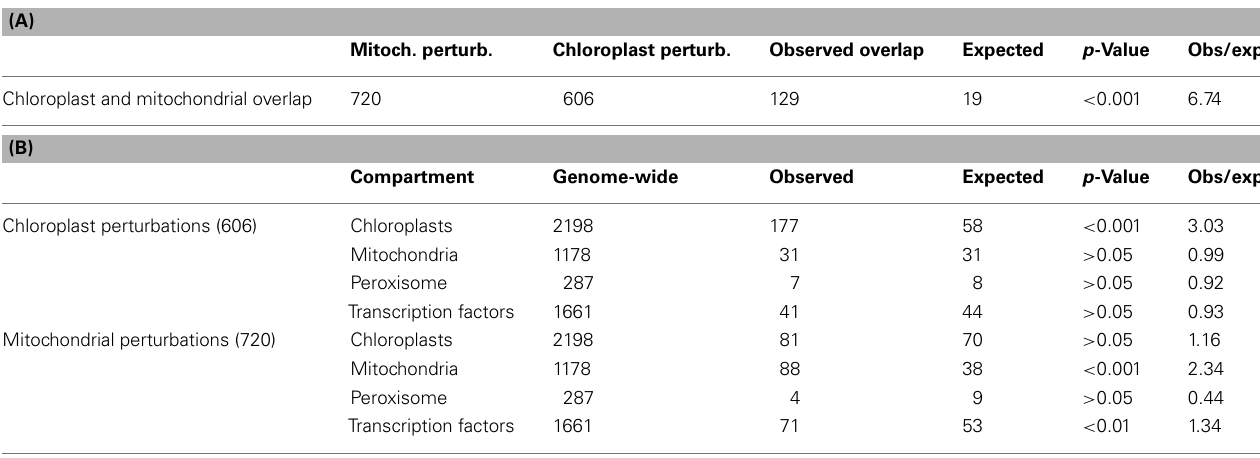
Table 2 | Perturbation of mitochondrial and chloroplast function triggers overlapping but targeted expression changes.